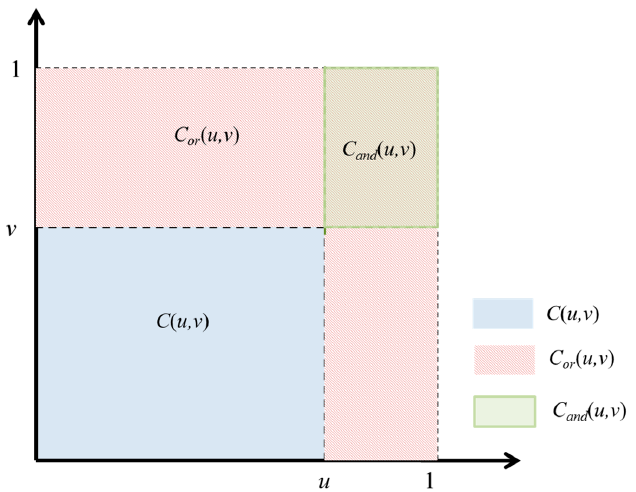
Figure 4. Sketch of the relationships between C ( u , v ), C or ( u , v ), and C and ( u , v ).